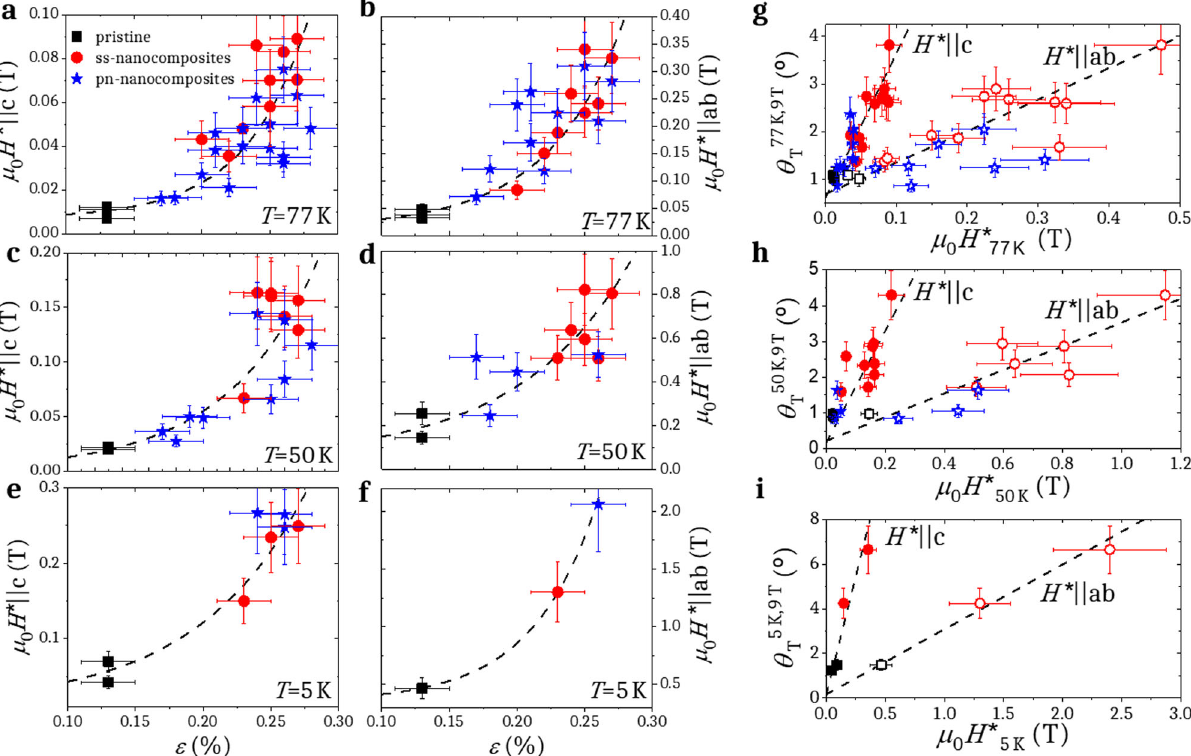
Fig. 4 Exponential H *( ε ) and linear θ T ( H *) trends. For (black) pristine, (red) ss-nanocomposites and (blue) pn-nanocomposites: μ 0 H * at ( a , b ) 77 K, ( c , d ) 50 K and ( e , f ) 5 K for ( a , c , e ) H * | | c and ( b , d , f ) H * | | ab versus nanostrain and θ T at 9 T as a function of μ 0 H * at ( g ) 77 K, ( h ) 50 K and ( i ) 5 K for H * | | c (closed symbols) and H * | | ab (open symbols). Dashed lines are guides to the eye. Error bars are determined by the standard deviation of iterative measurements for μ 0 H * and θ T and by the standard error of the fi tting of the Williamson-Hall method 74 in the case of ε .